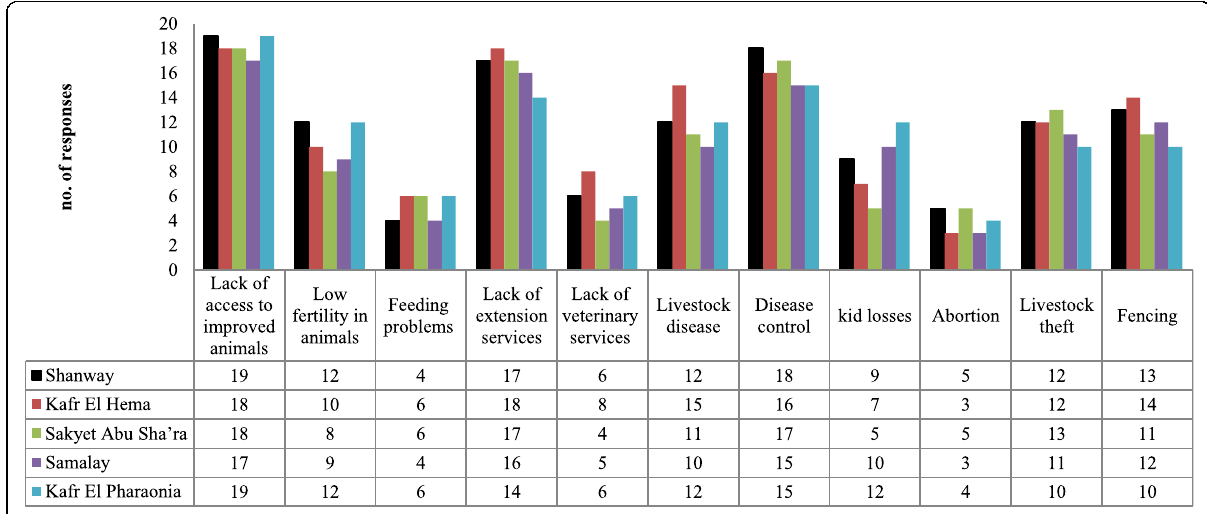
Fig. 2 Constraints for goat farmers in rural areas of the Nile Delta in